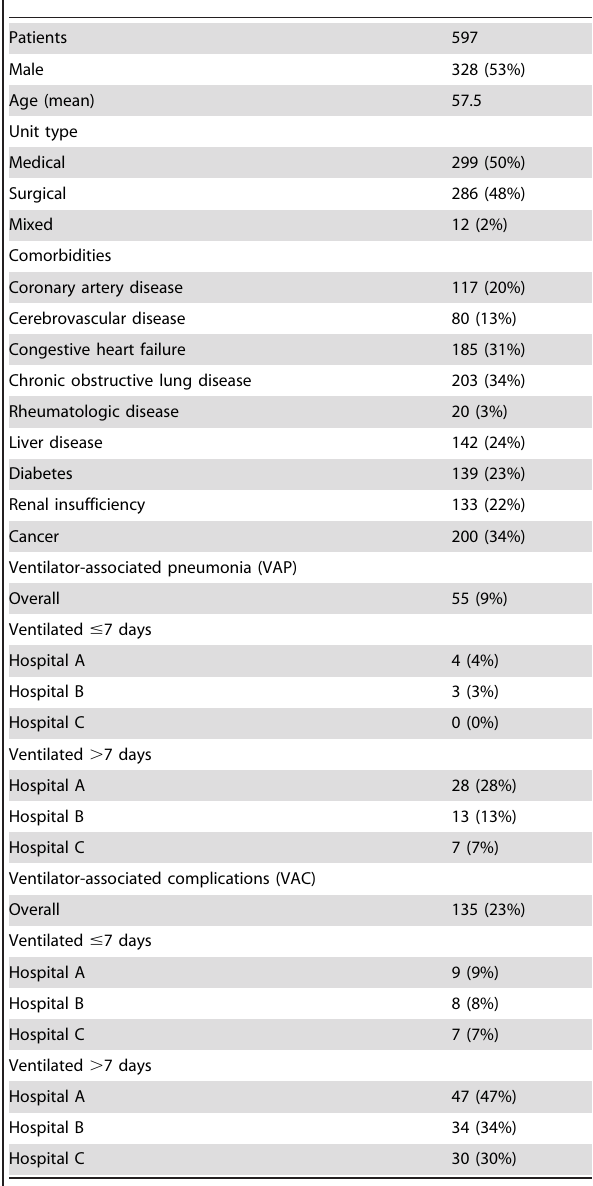
Table 1. Patient